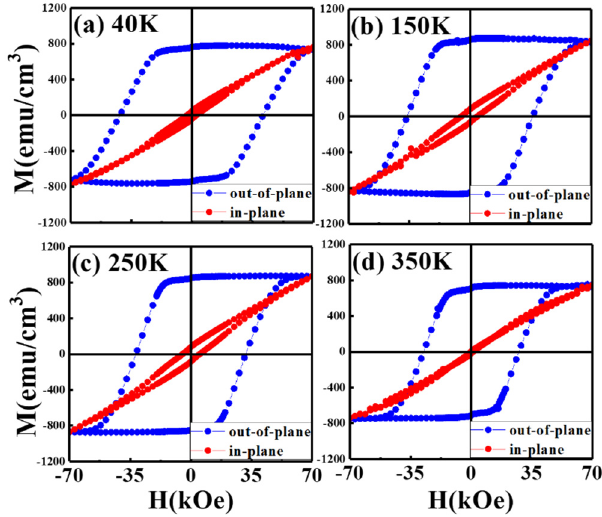
Figure 2. Out-of-plane and in-plane field dependent magnetization loops of the FePt (B, Ag, C)(8 nm)/MoC/MgTiON/CrRu films measured at ( a ) 40 K, ( b ) 150 K, ( c ) 250 K, ( d ) 350 K.